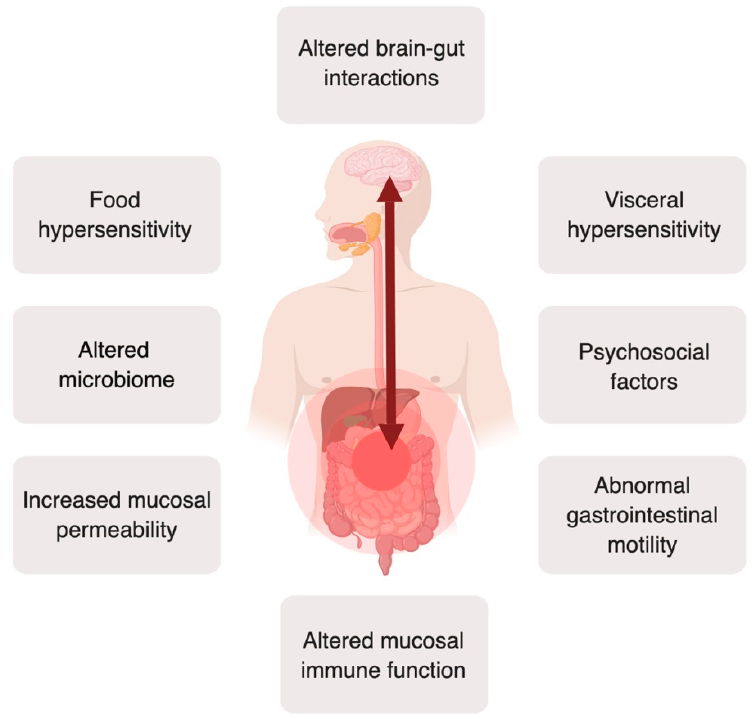
Figure 1. An overview of important pathophysiological factors in IBS. The current view of the heterogeneous IBS pathophysiology is that it is caused by altered brain-gut interactions, with various alterations and abnormalities along the brain-gut axis in subsets of IBS patients. Created with BioRender.